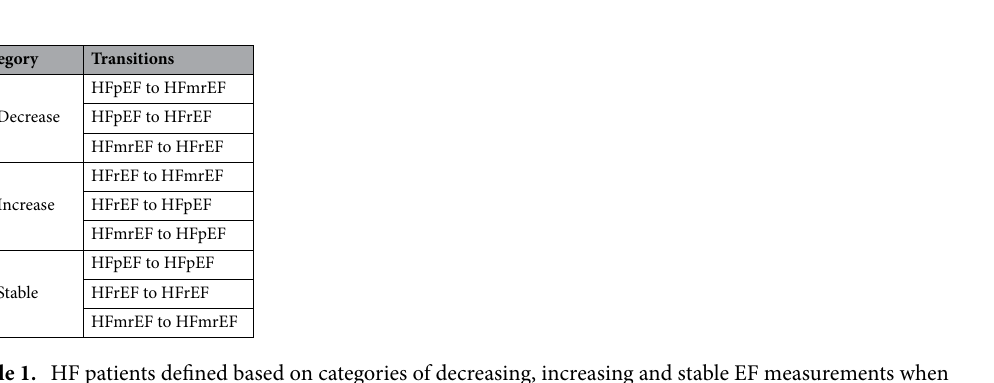
Figure 2. HF patients identified as EF-Stable, EF-Decrease and EF-Increase.